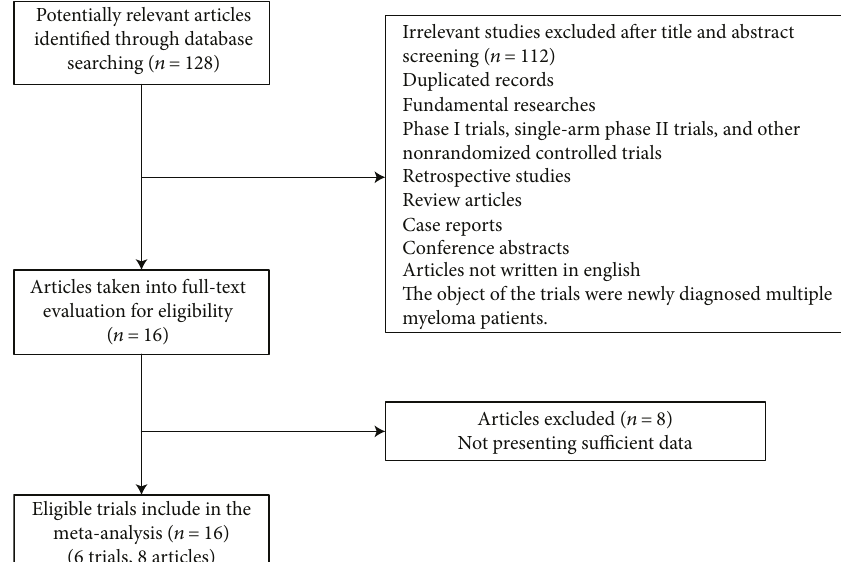
Figure 1: Identi fi cation and selection process of clinical trials included in the